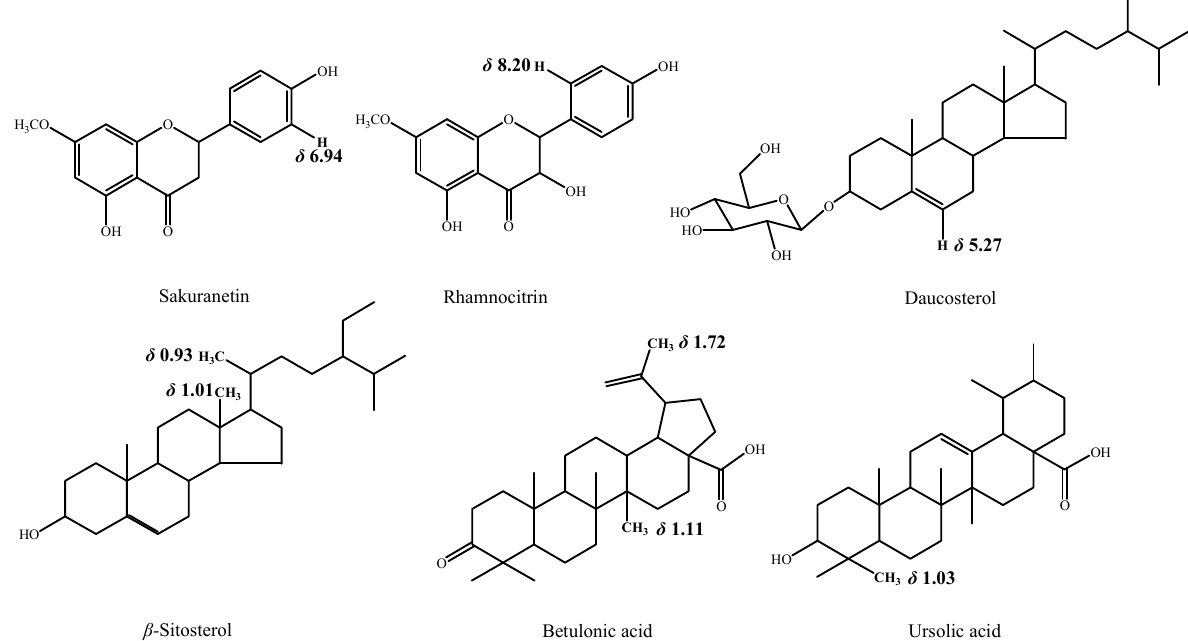
Figure 3. Some chemical structures with the specific hydrogen atoms corresponding to the mentioned chemical shifts.